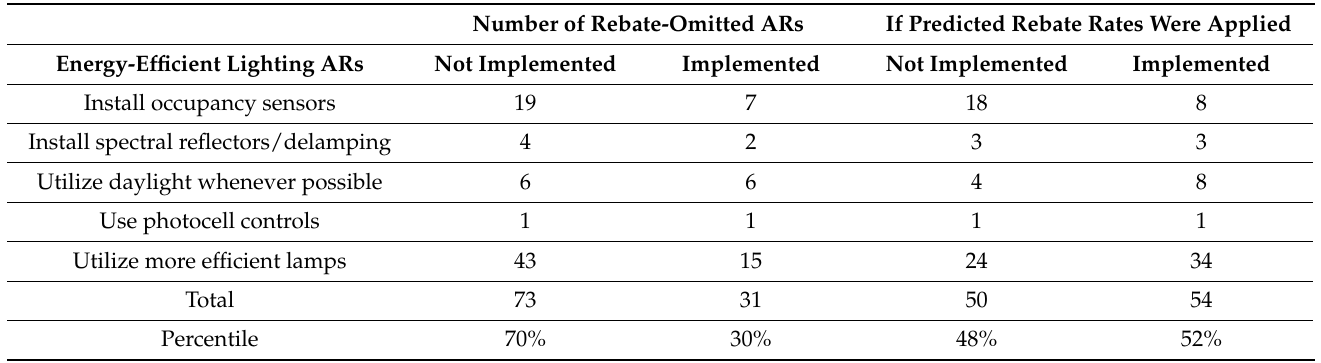
Table 7. Implementation results from the GBM model based on the AR type. Number of Rebate-Omitted ARs If Predicted Rebate Rates Were Applied